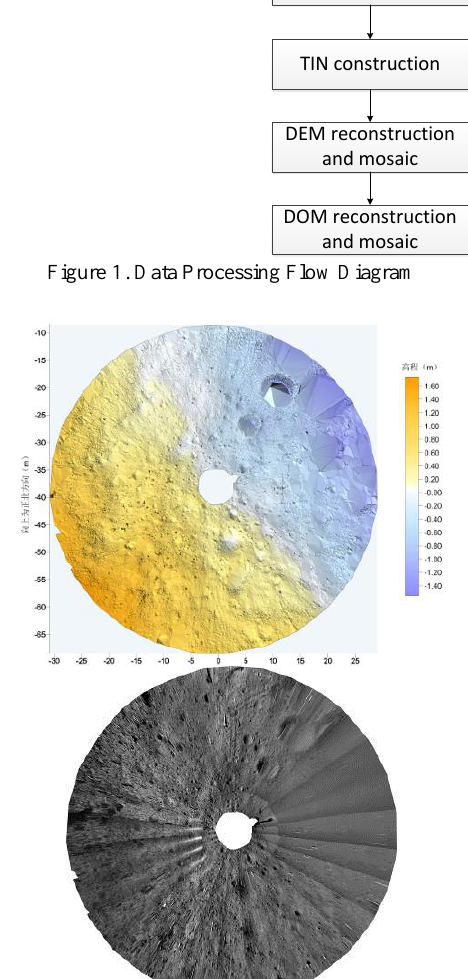
Figure 2. Reconstructed DEM and DOM near points S3